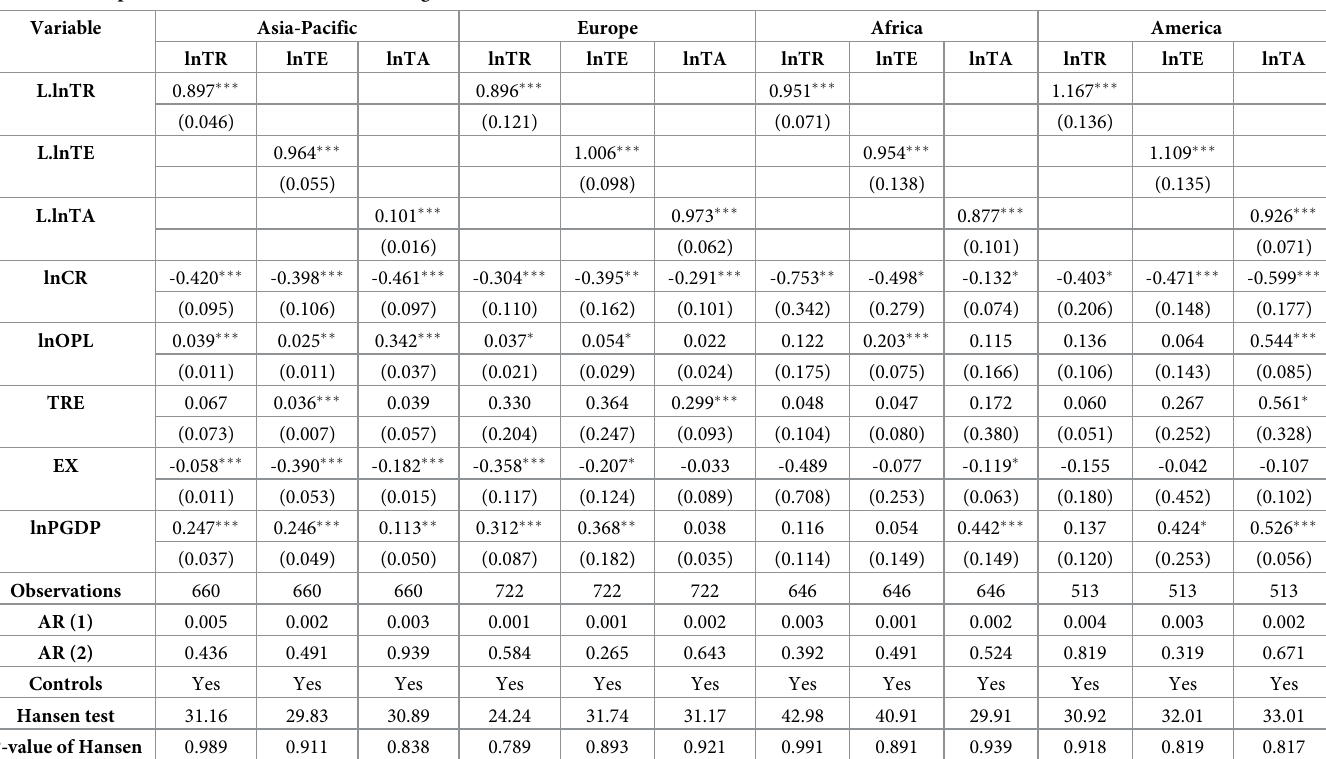
Table 9. The impact of CR on tourism in different